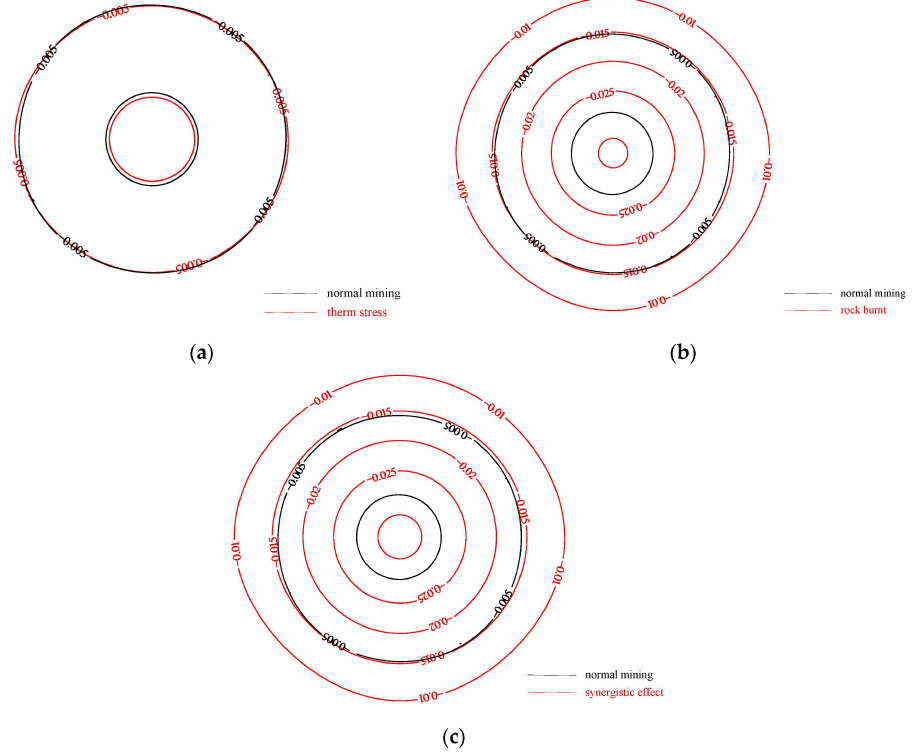
Figure 4. Surface subsidence in various conditions (m). ( a ) Conventional mining and thermal stress only. ( b ) Conventional mining and coal and rock combustion. ( c ) Conventional mining and